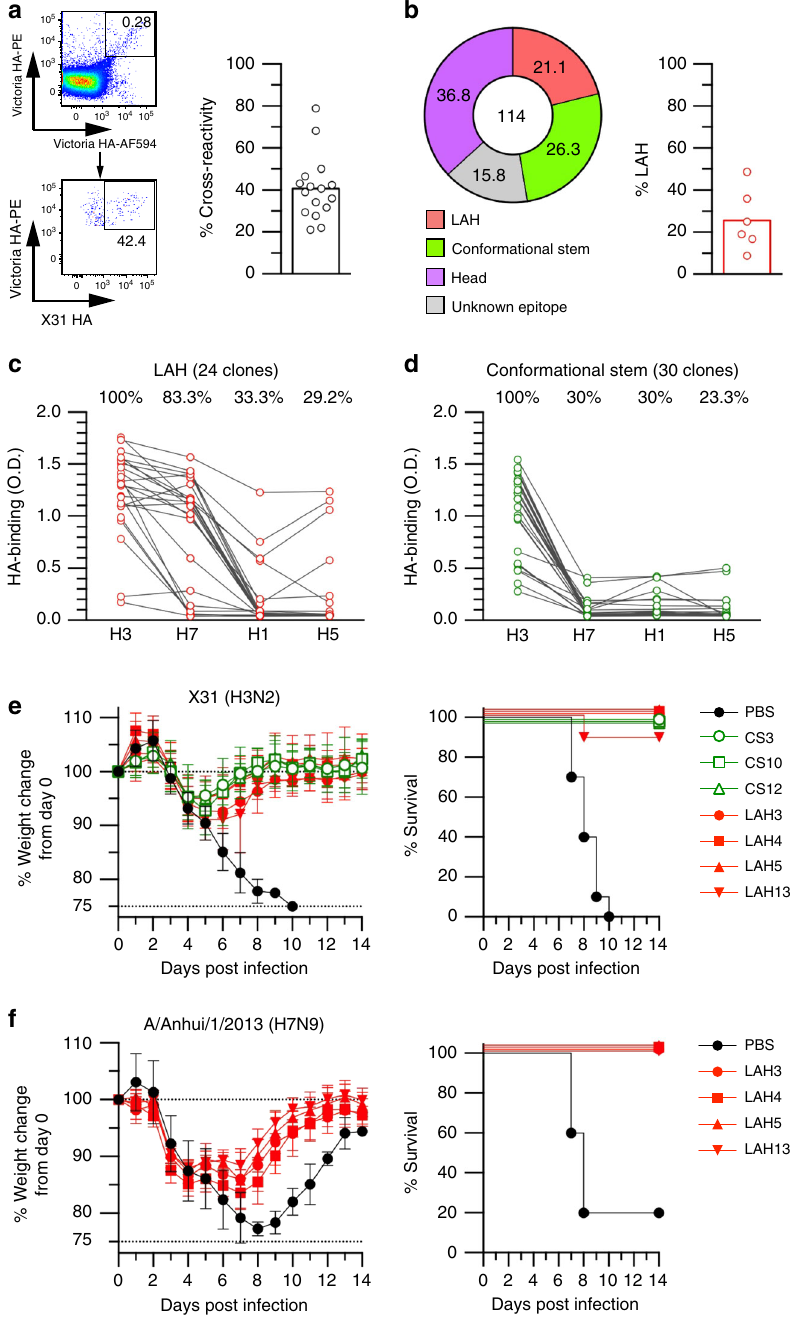
Fig. 2 Human LAH-binding B cells are present in cross-reactive memory fraction. a Victoria HA-binding IgG + memory B cells (CD19 + CD27 + ) were identi fi ed in human PBMCs as double positive cells (Victoria HAs labeled by AlexaFluor594 and PE) and cross-reactivity to X31 HA was enumerated as gated. Cross-reactivity was expressed as the percentage of X31 HA-binding cells over Victoria HA-binding cells. Each circle represents the result of an individual donor. b High-throughput epitope mapping analysis identi fi ed multiple classes of conserved epitopes for cross-reactive memory B cells in humans. The data from pooled 6 donors is shown. LAH ratios are shown from individual donor. c Heterosubtypic HA reactivity of LAH-binding clones was examined by ELISA using the same rHAs with Fig. 1, except Victoria HA for H3 in Fig. 2. Each dot represents the result from individual clone. d Heterosubtypic HA reactivity of CS-binding clones was examined by ELISA under the same condition with c . Each dot represents the result from individual clone. e , f Protective function of CS (green) and LAH (red)-binding IgG2a (100 μ g per mouse) was assessed in the mice after lethal dose of homologous H3N2 (X31; 5 x LD50) infection e and heterosubtypic H7N9 (A/Anhui/1/2013; 1 x LD50) infection f . Body weight (left) and survival (right) of infected mice were monitored daily. The combined data from two independent experiments ( n = 9 – 10 per group) are shown. Values represent mean ± s.d. Source data are provided as a Source Data fi